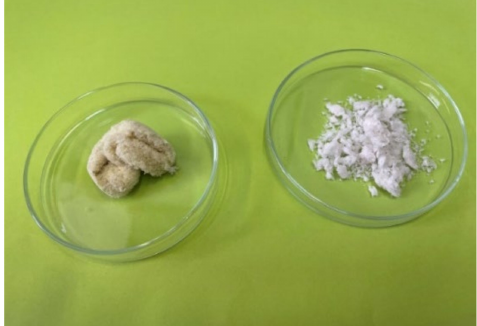
Figure 1. Cuticulin (left) and reprecipitated chitosan